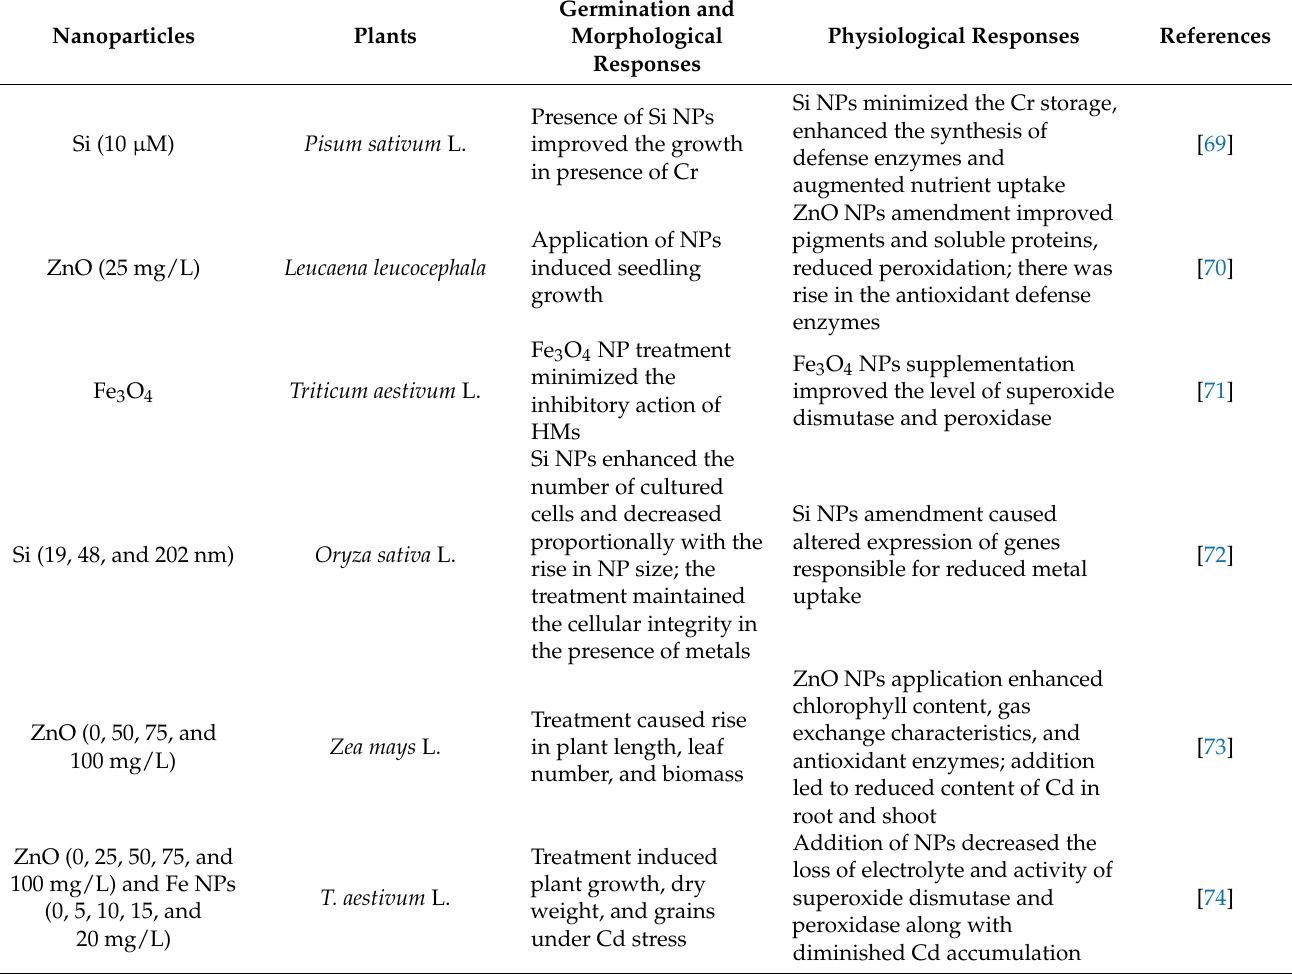
Table 1. Applications of NPs in the mitigation of HMs stress by altering the morphophysiological responses of plants. Nanoparticles Plants